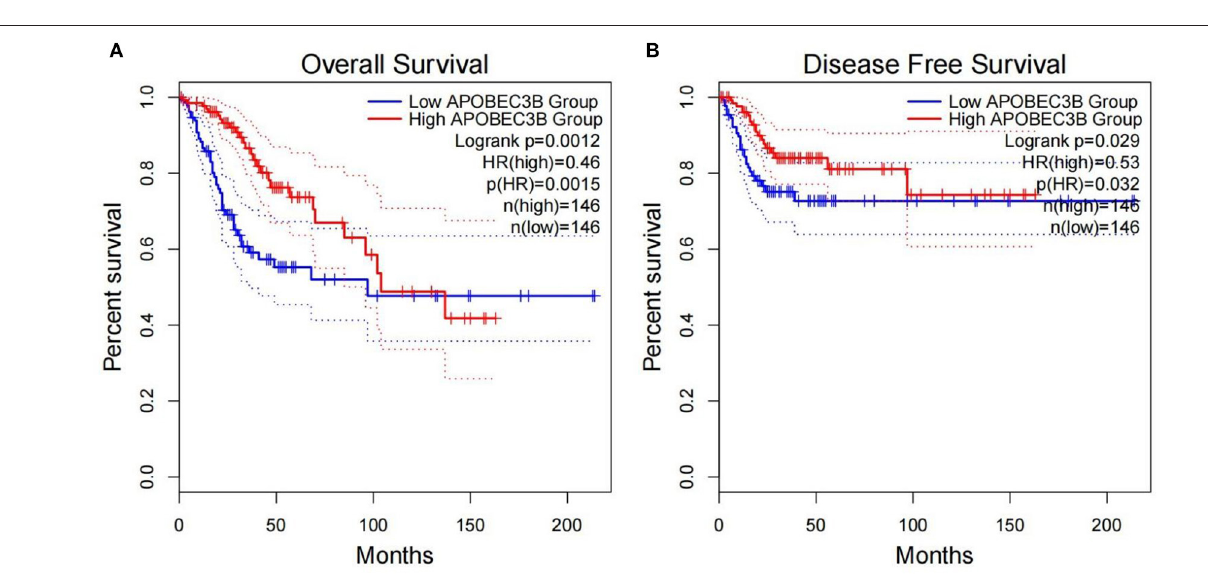
associated with prognosis in patients with CC ( Figure 9 ).